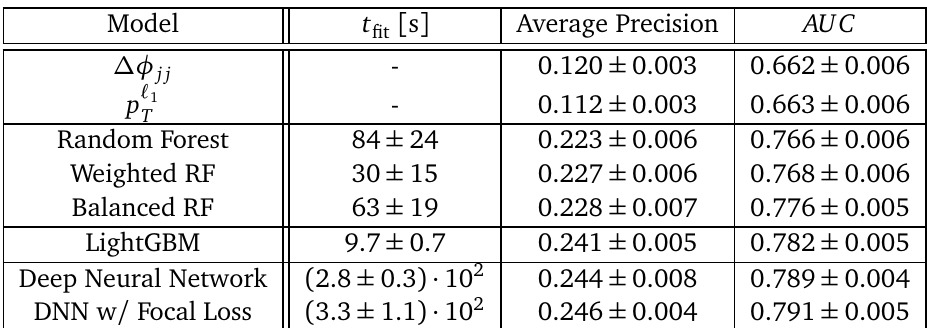
Table 1: Results of the five-fold cross validation for classifying LL events